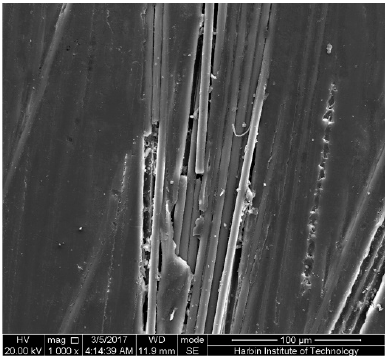
Figure 16. The top surface in the mid-span region of the epoxy-based CFRP samples subjected to 58% strain level and seawater immersion at 60 °C for 6 months.